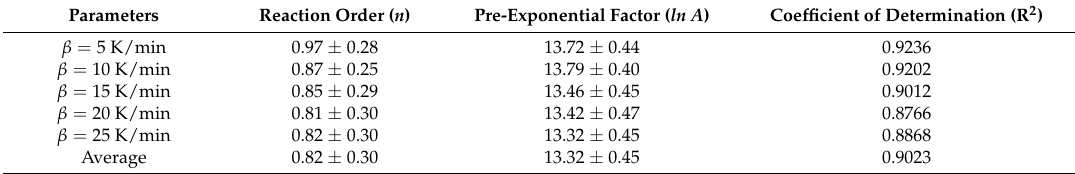
Table 6. The reaction order and pre-exponential factor of Stage 1 at a variety of heating rates. Parameters